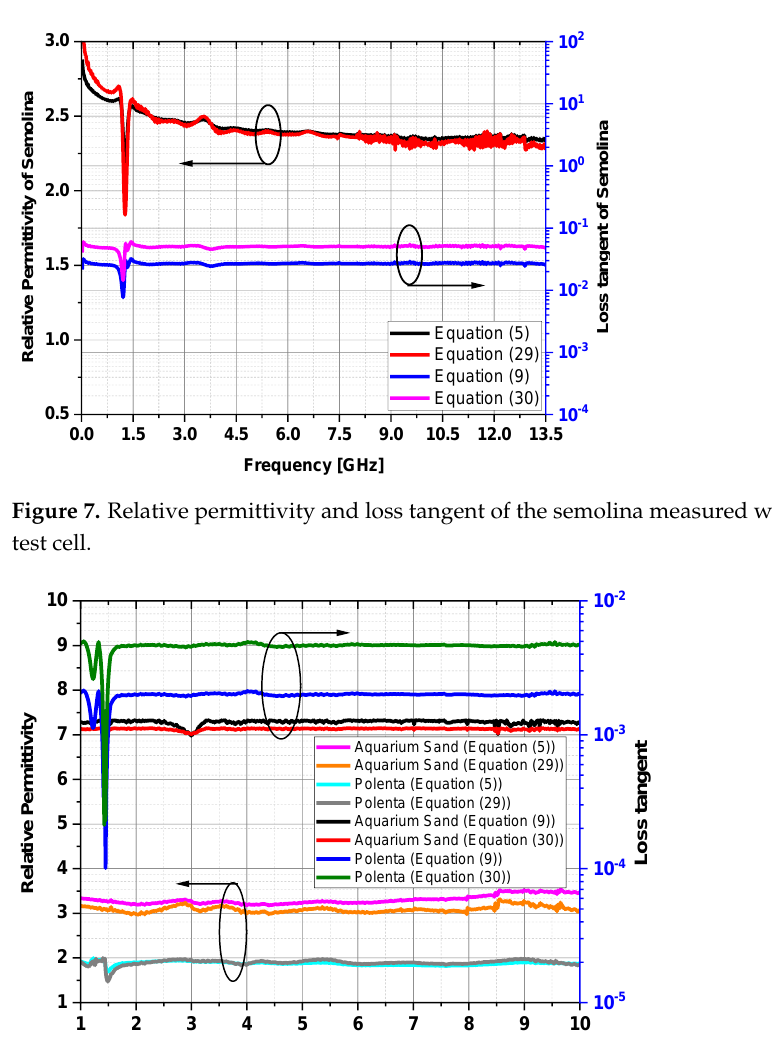
Figure 6. Relative permittivity and loss tangent of the Q-Cell 5020 measured with the circular coaxial test cell.